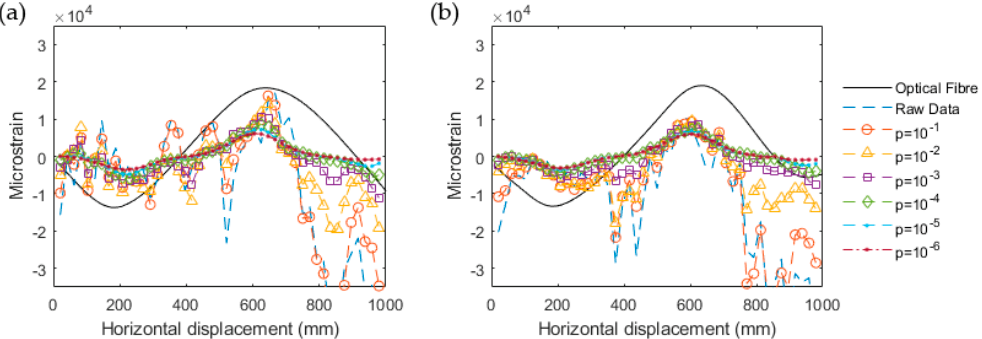
Figure 17. In-plane deformation test Step 2 strain ( a ) at 180 mm and ( b ) 320 mm of optical fibre and di ff erent cubic smoothing spline weighting parameter from 10 − 1 to 10 − 6